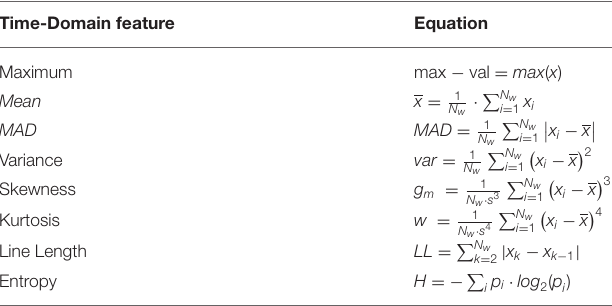
TABLE 4 | Assumed equations for the Time-domain features. Time-Domain feature